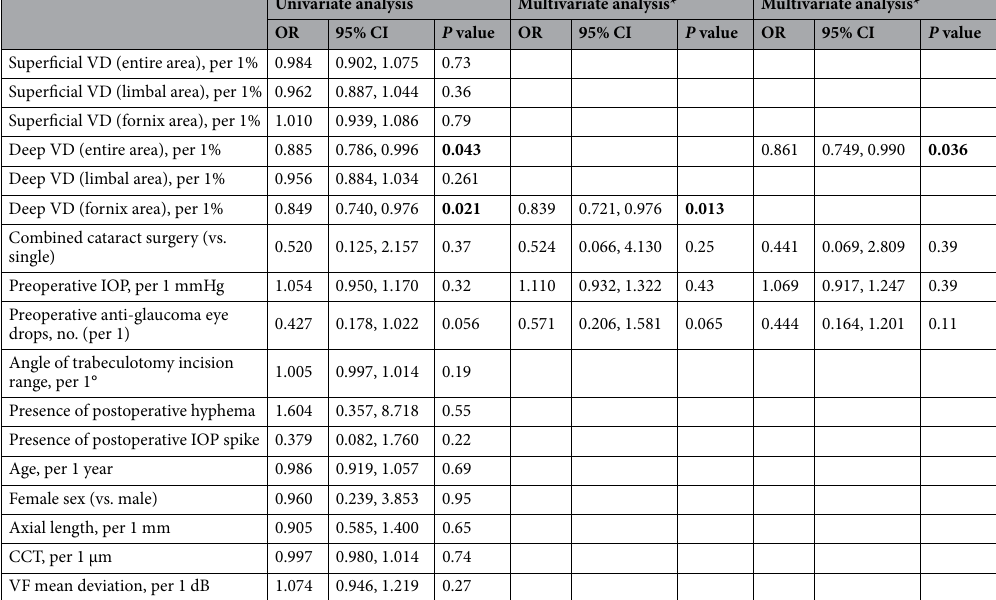
(Table 4). The deep VD in the fornix area (B, 1.486; 95% CI, 0.227–2.745; β = 0.343; P = 0.022) and preoperative IOP (B, − 2.083; 95% CI, − 2.999 to − 1.168; β = − 0.621; P < 0.001) were significantly associated with the percent changes in IOP.